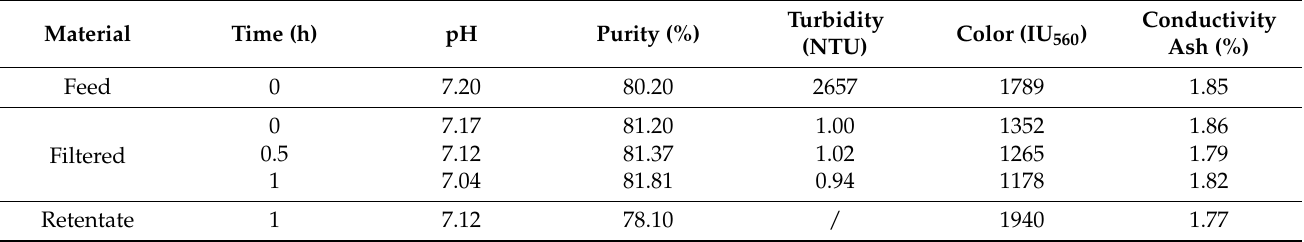
Table 5. The typical quality parameters of feed and permeate streams obtained in run